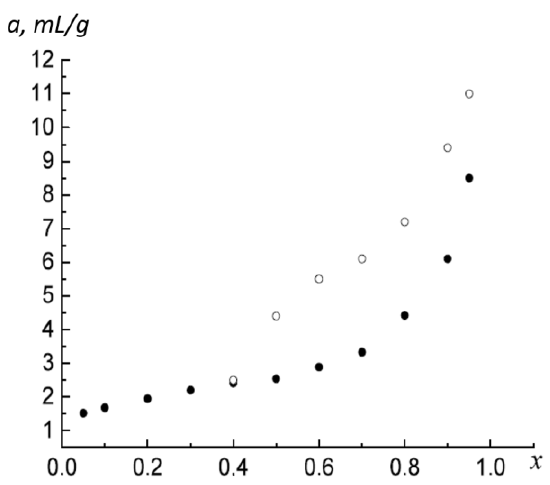
Figure 1. N 2 gas adsorption • / desorption ◦ isotherm of coal sample (BD3) [15].